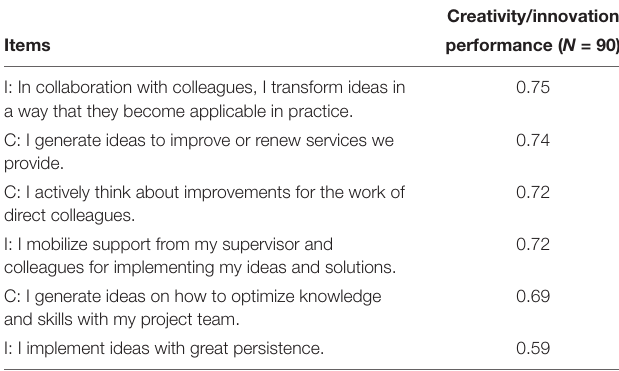
TABLE 3 | Pattern and structure matrix of PCA with varimax rotation for a one-factor solution of creativity and innovation